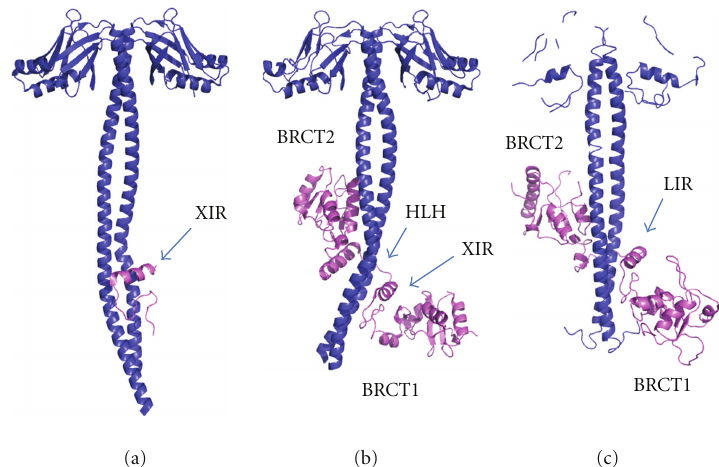
Figure 12: Crystal structures of LigIV/XRCC4 and Lif1p-Lig4p. Conserved XRCC4 or Lif1 interaction region of LigIV (XIR) or Lig4p (LIR) are indicated with blue arrows. (a) XRCC4(residues 1–213)(blue) and XIR (violet) (PDB code: 1IK9). (b) XRCC(residues 1–203)(blue) and BRCT domains of LigIV(residues 654–911)(violet) (PDB code: 3II6) (c) Lif1p(residues 1–246)(blue) and BRCT domains of Lig4p(residues